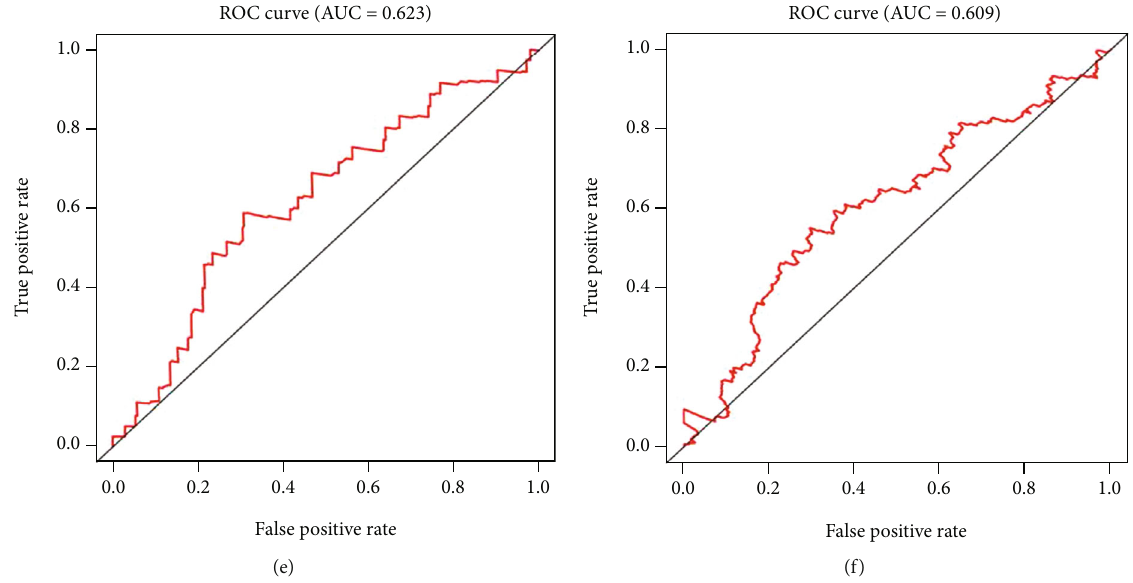
Figure 6: Kaplan-Meier for the risk scoring system based on 2 M6A-related genes ( P < 0 : 05 as the statistical cuto ff value). (a) TCGA training cohorts. (b) TCGA validation cohorts. (c) TCGA all LUAD samples. Time-dependent ROC curves. (d) TCGA training cohorts. (e) TCGA validation cohorts. (f) TCGA all LUAD samples.